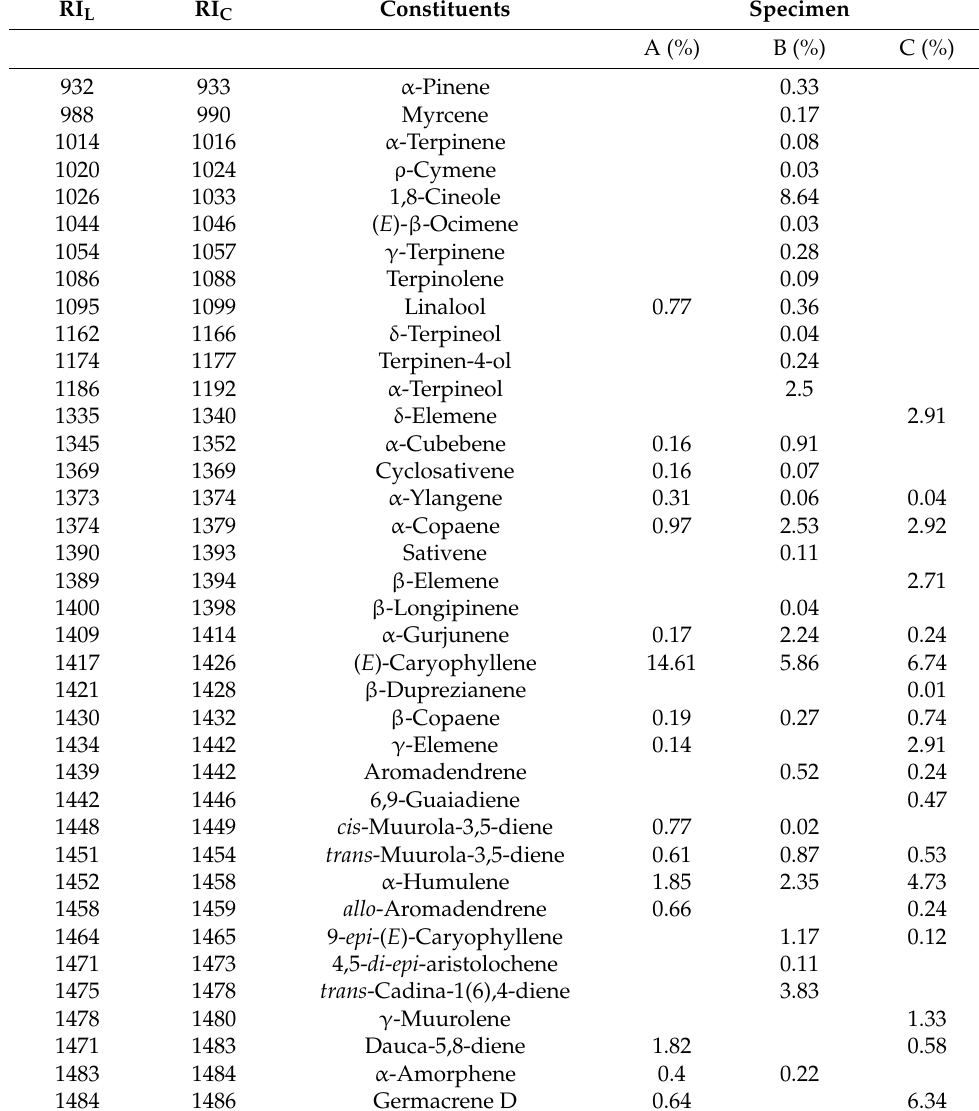
Table 1. Chemical composition of EOs isolated from Calycolpus goetheanus leaves through hydrodistil- lation. The concentration values of the compounds are relative to the percentage